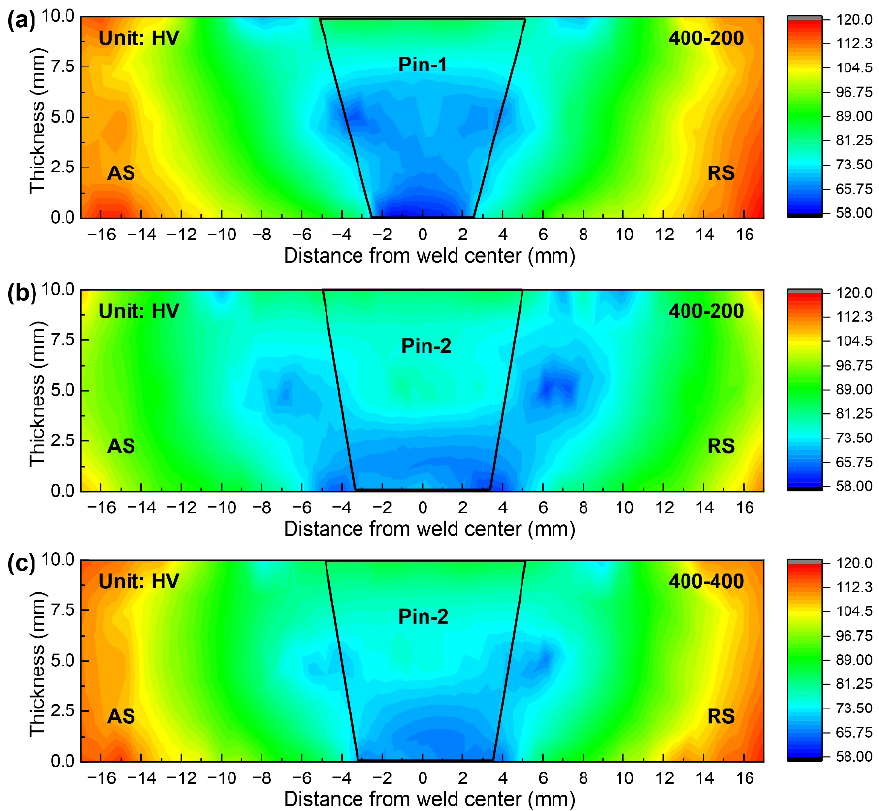
Figure 12. Microhardness maps of typical joints ( a ) Pin-1-400-200, ( b ) Pin-2-400-200, and ( c ) Pin-2- 400-400.